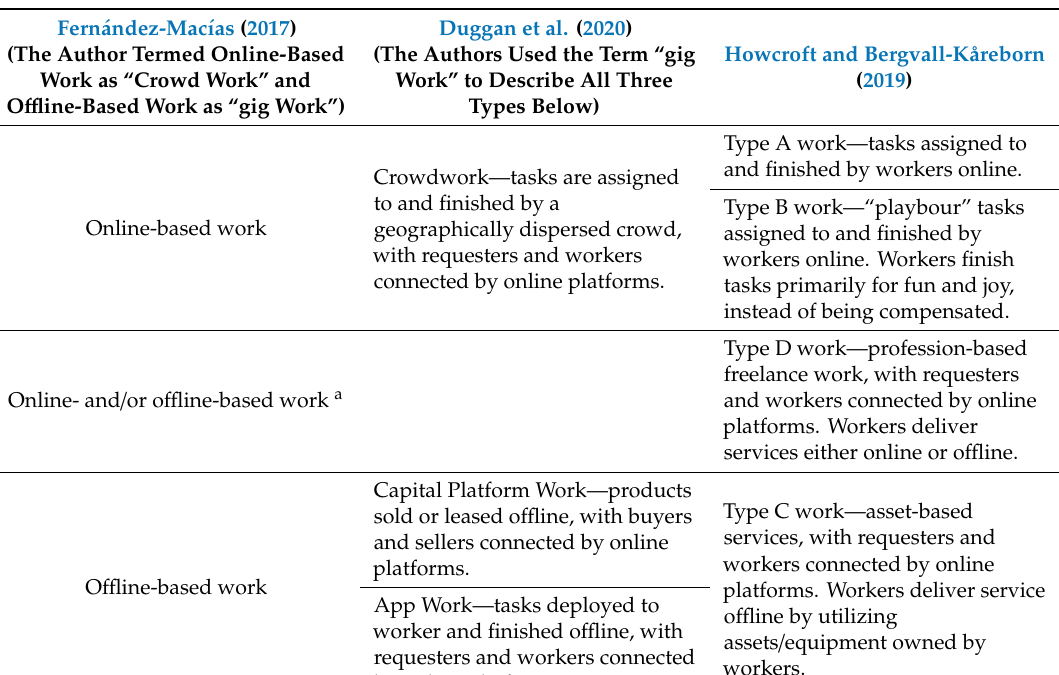
Table 1. Categorization of